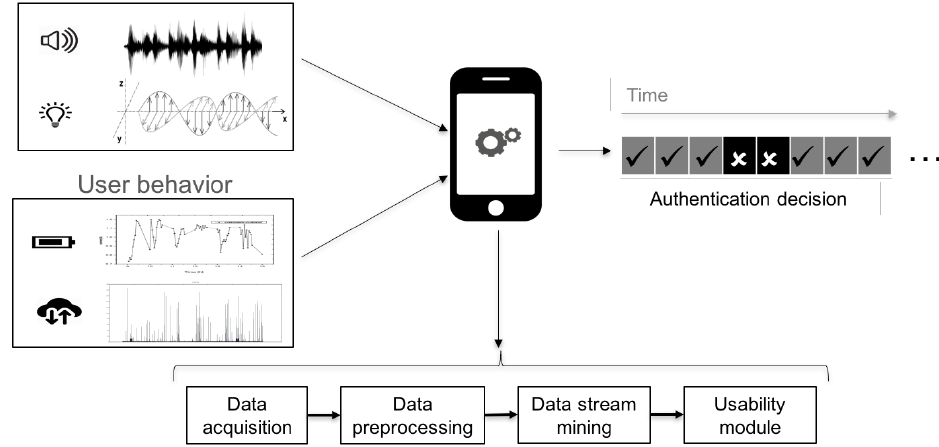
Figure 1. Overview of the proposed continuous authentication